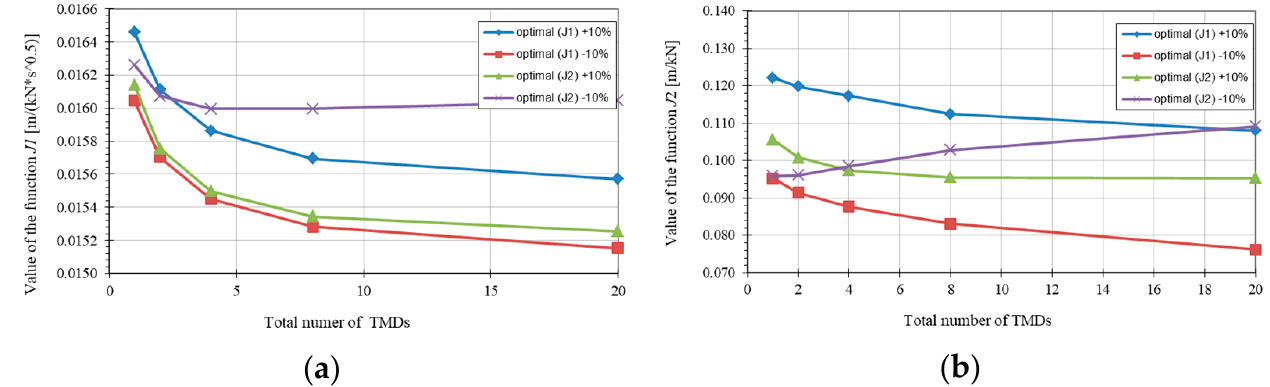
Figure 13. Objective function value, in the case of primary system mistuning (10% increase and drop of mass), based on the optimal parameters obtained from J 1 and J 2, depending on the number of TMDs: ( a ) value of J 1; ( b ) value of J 2.